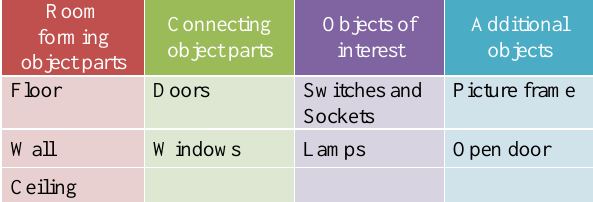
Figure 3. Selection of ground truth images at the bottom with the FCN segmented images on the top.